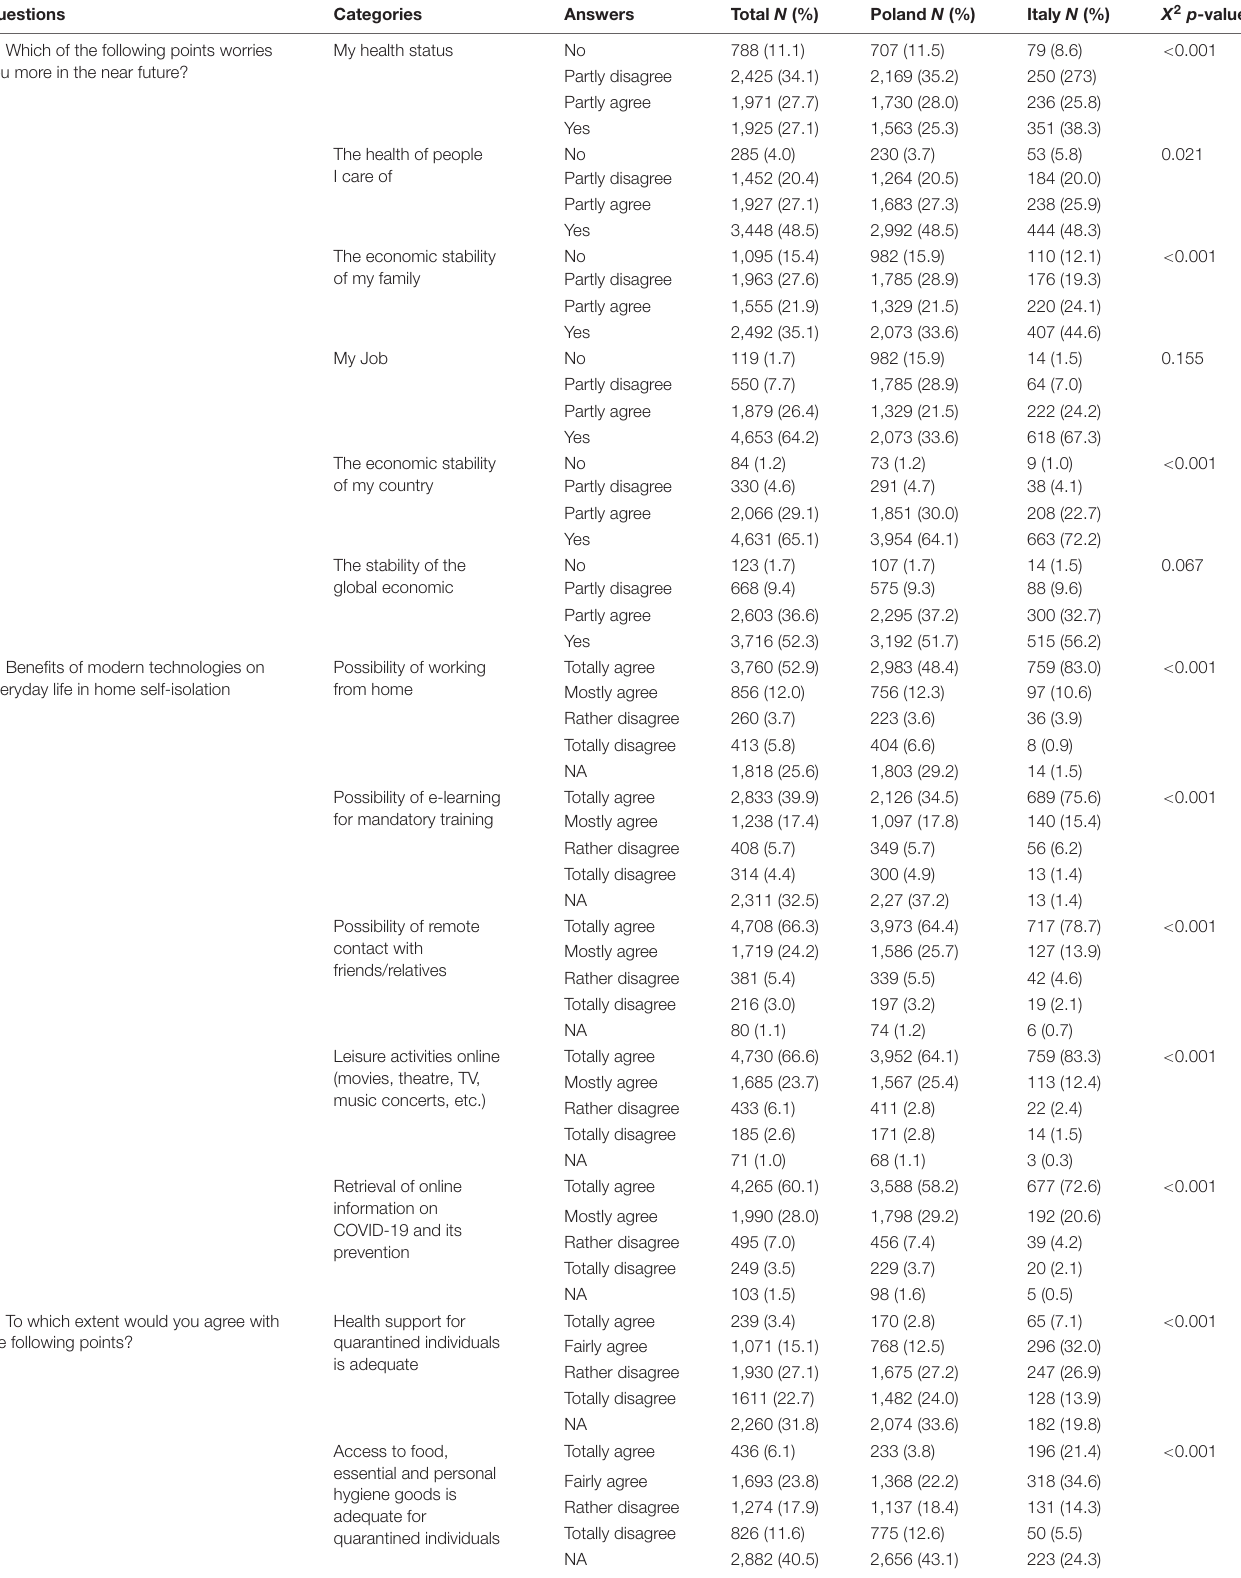
TABLE 2 | Distributions of attitudes/perceptions on health protection measures against the spread of COVID-19 during the first epidemic wave by country.